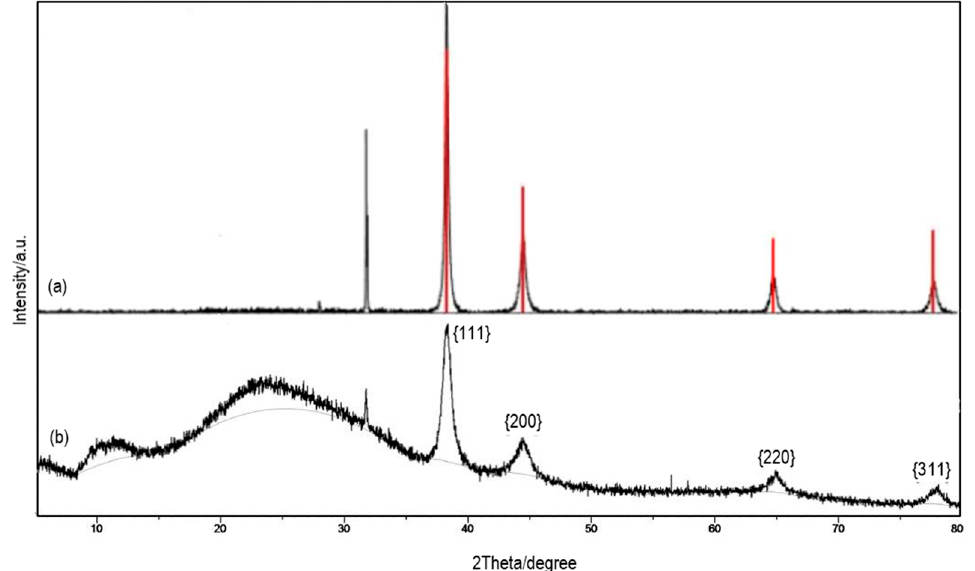
Figure 7. XRD pattern of ( a ) bare gold nanoparticles and ( b ) branched gold nanoparticles stabilized with gelatin concentration of 2.5% (w/v).